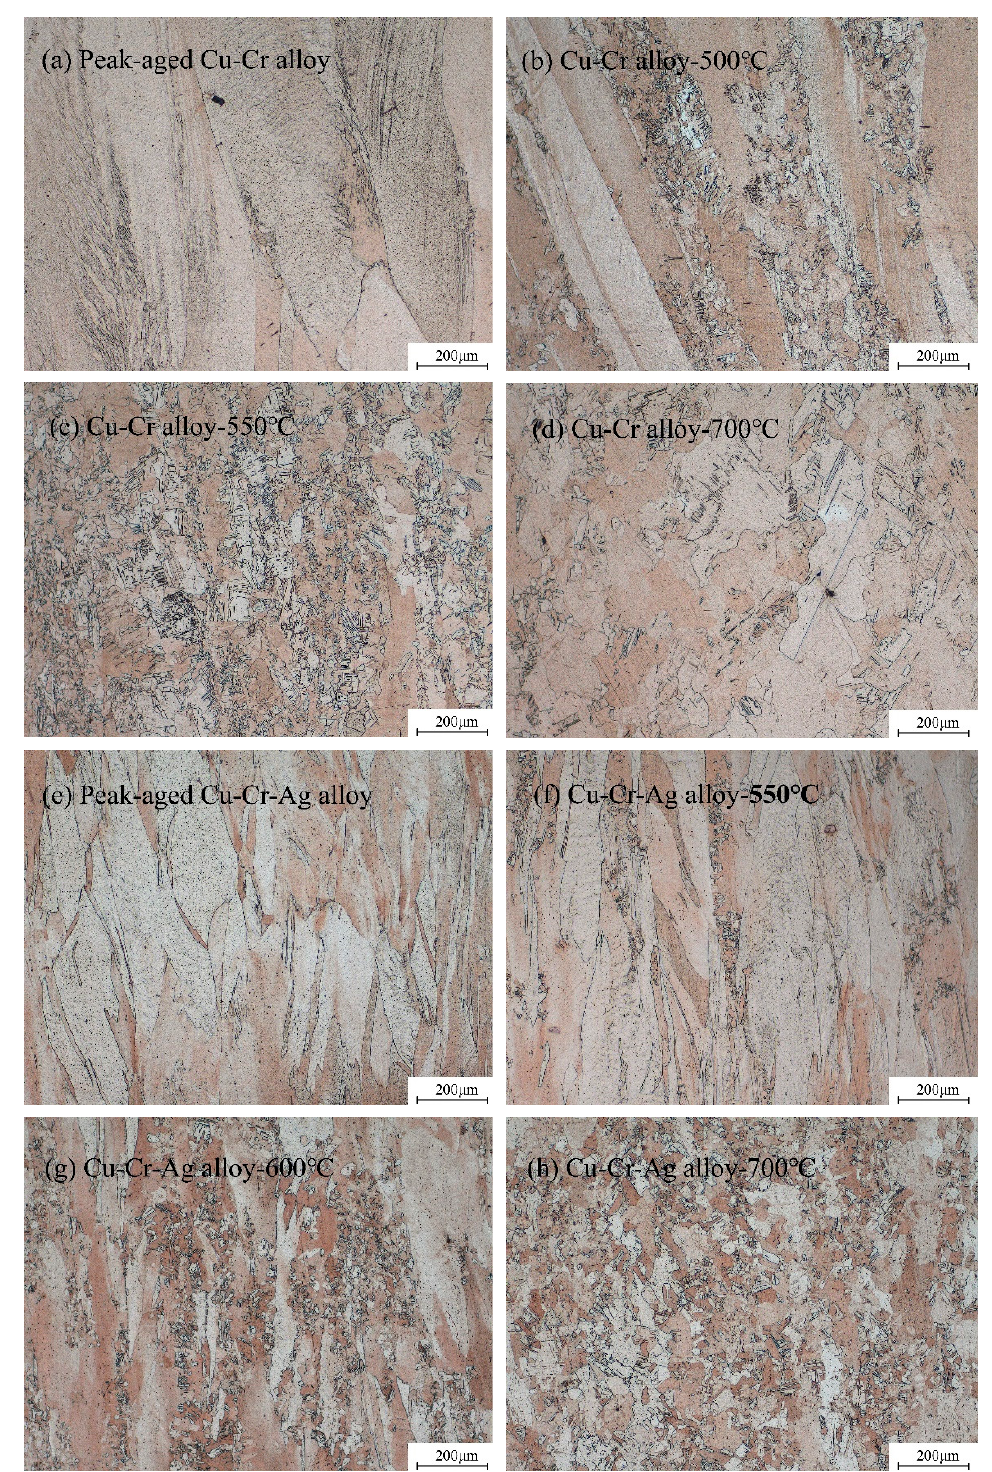
Figure 5. Microstructures of ( a – d ) Cu–Cr and ( e – h ) Cu–Cr–Ag alloys annealed at different temperature levels for 1 h.